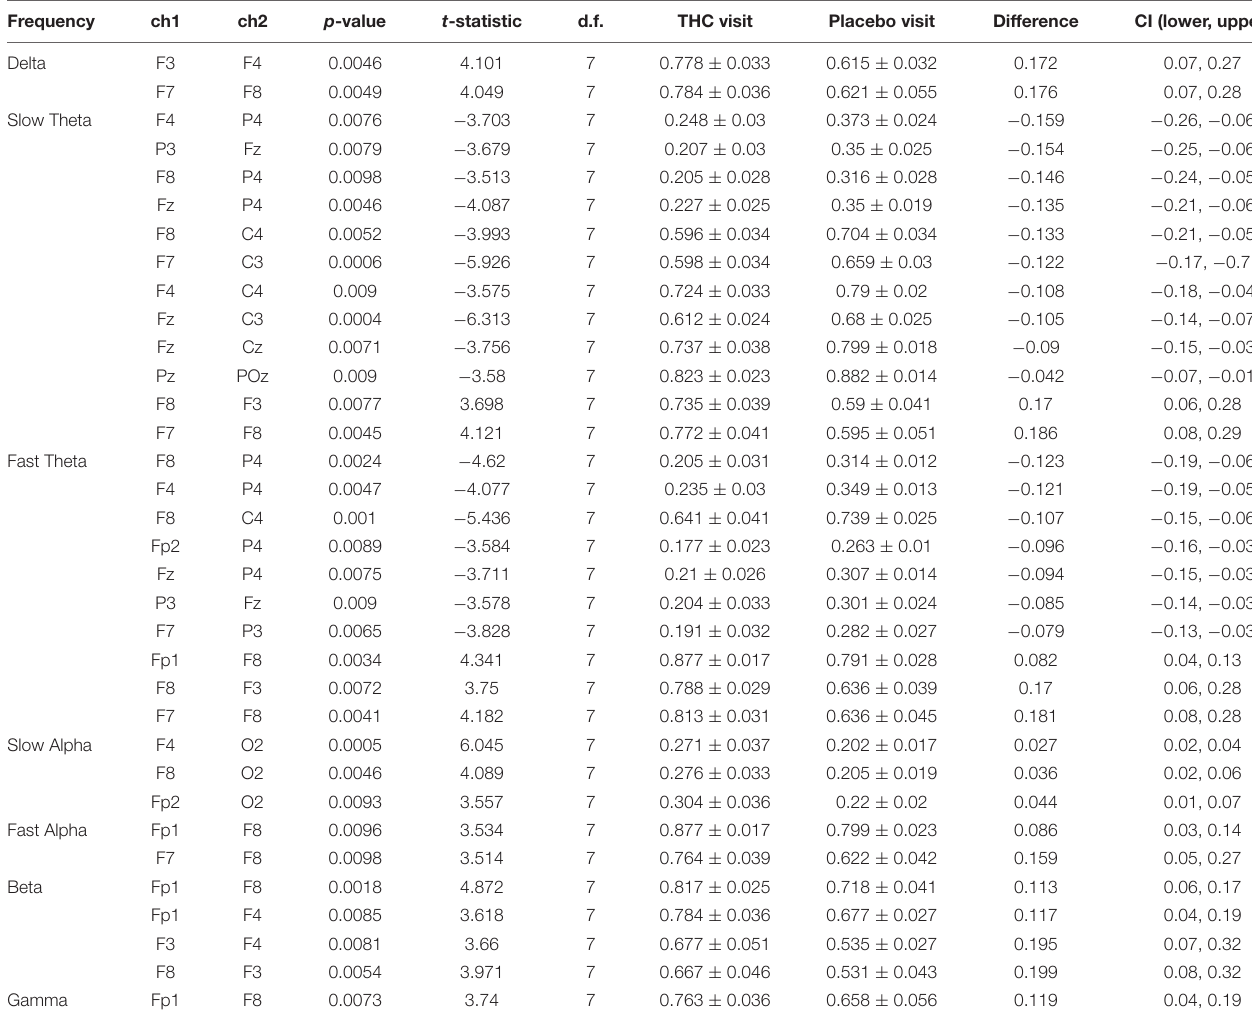
TABLE 6 | Coherence statistics for resting state eyes